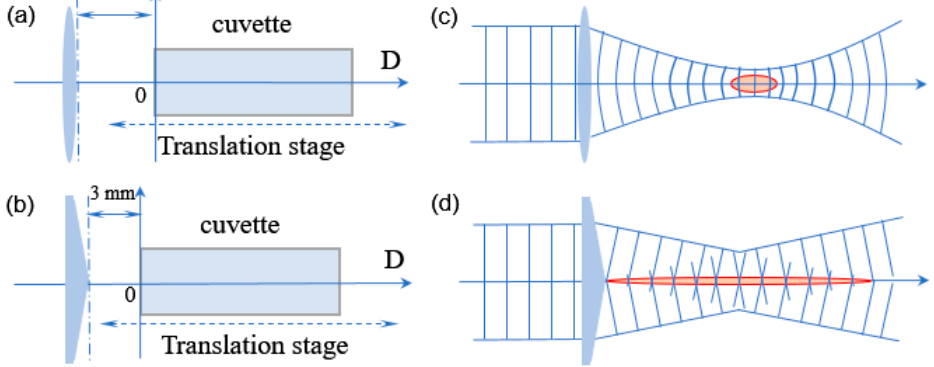
Figure 3. Definition of the ‘zero position’ in the experiment (i.e., D = 0 mm) in the case of using the ( a ) focusing and ( b ) axicon lenses. Schematic diagram for Gaussian beam which passes the ( c ) focusing and ( d ) axicon lenses. The red areas in ( c , d ) denote the focal region.